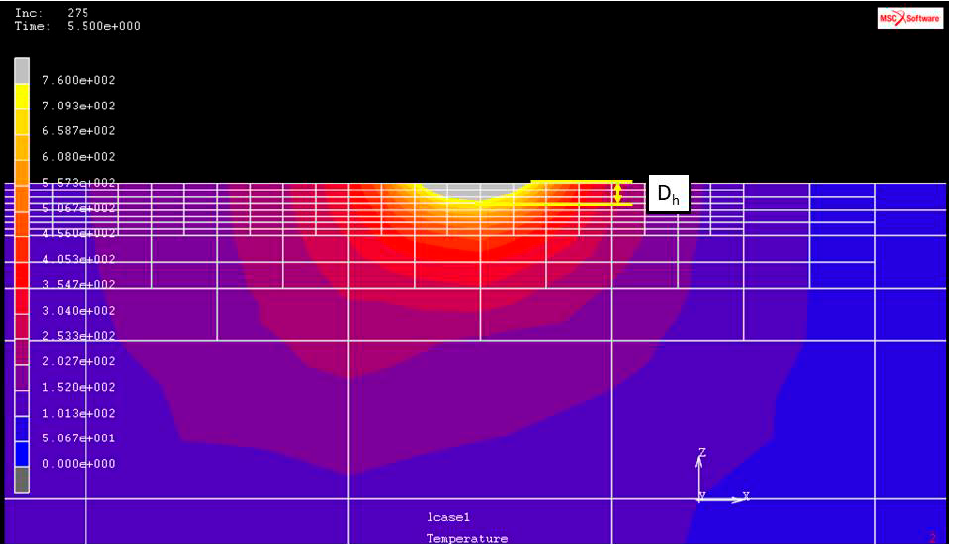
Figure 6. Example of the hardening depth ( D h ) caused by the application of a laser heat source.